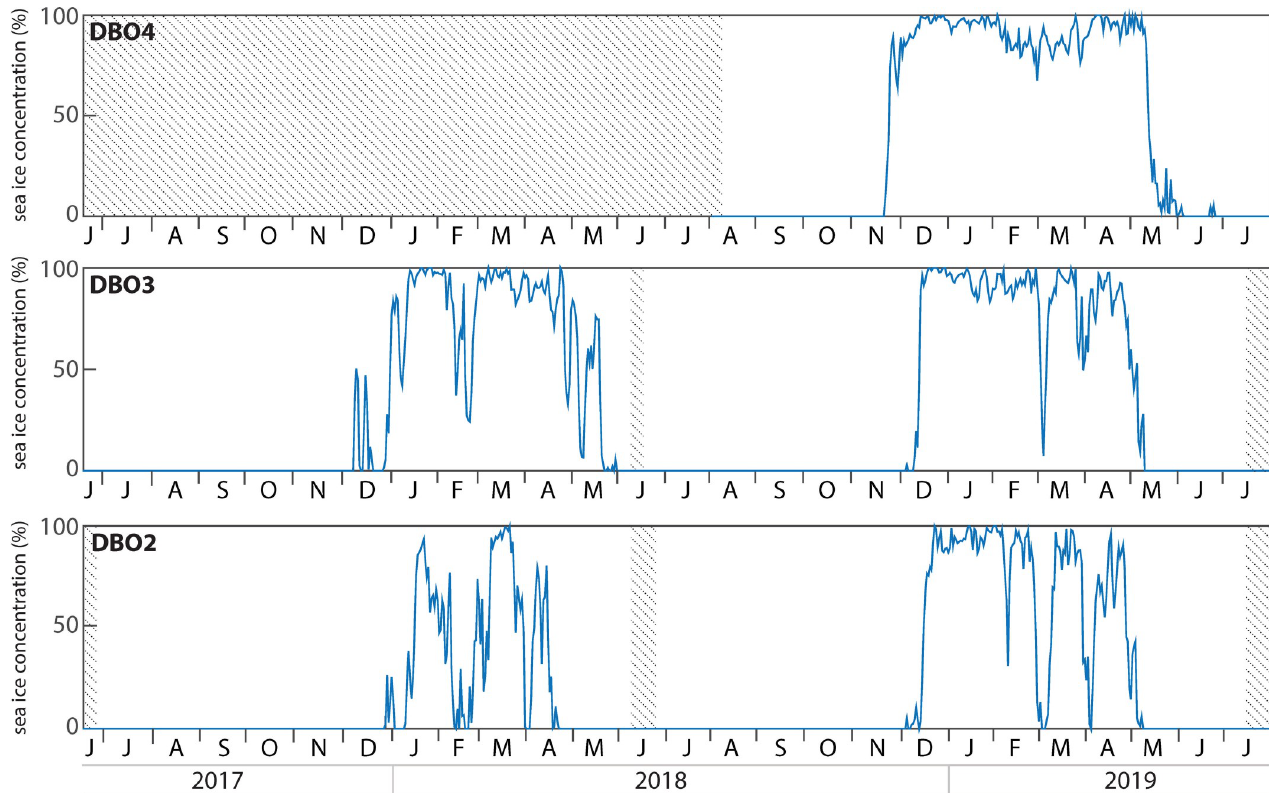
Fig 2. Daily sea ice concentration retrieved for a delimited region above each mooring site. Shaded areas represent periods without data.